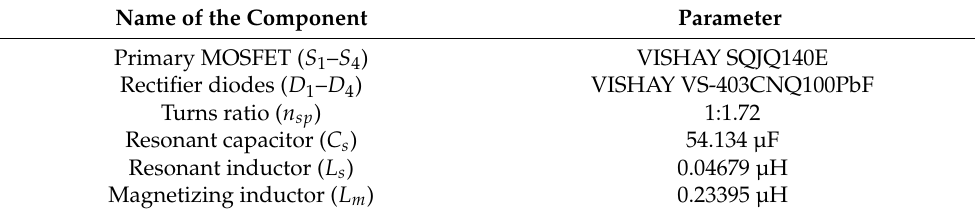
Table 5. Parameters pertaining to various circuit